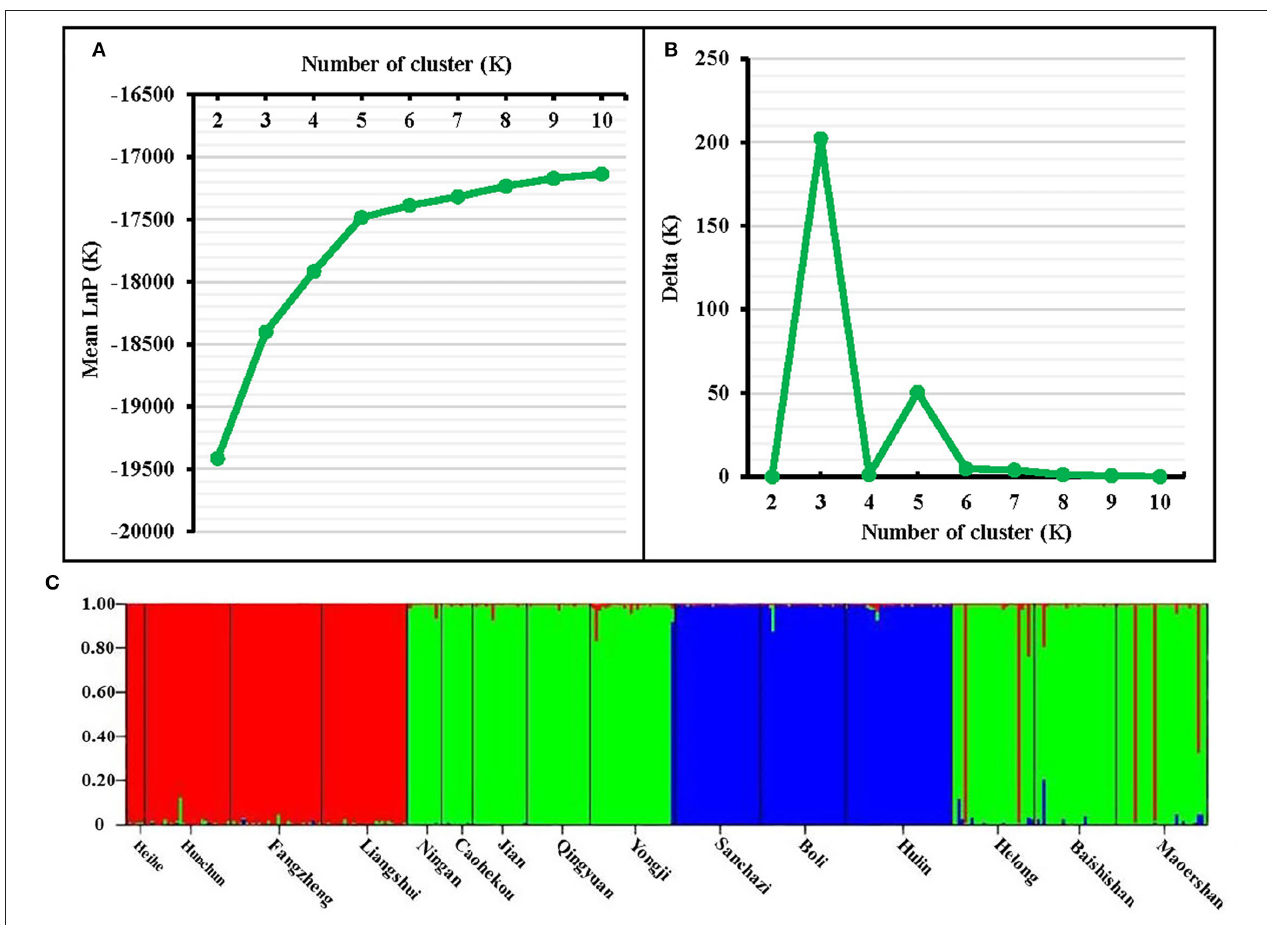
FIGURE 3 | STRUCTURE analysis of the natural population of J. mandshurica based on 15 EST-SSRs. (A) Calculation of population structure using Mean LnP (K). (B) Relations between the optional number of cluster K and Delta K. (C) Genetic structure map of 15 natural populations of J. mandshurica based on STRUCTURE analysis ( K =